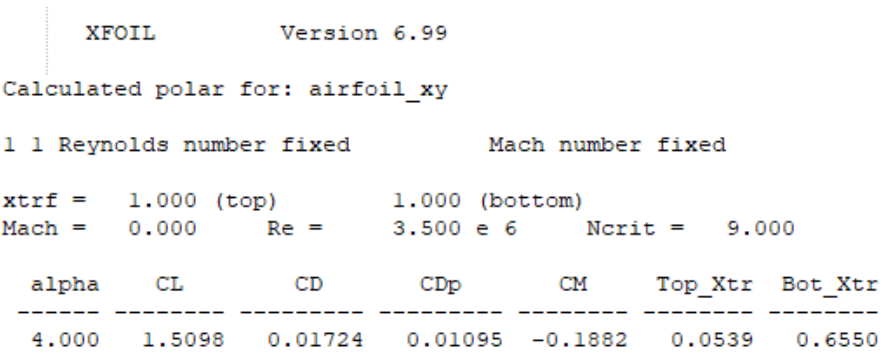
Figure 33. Morphed NACA 23012 Xfoil 6.99 polar results — Re 3.5 × 10 6 , 𝛼 4°, LE (4°) TE ( − 15°). Table 15. NACA 23012 Xfoil 6.99 aerodynamic results segments wise distribution — Re 3.5 × 10 6 , 𝛼